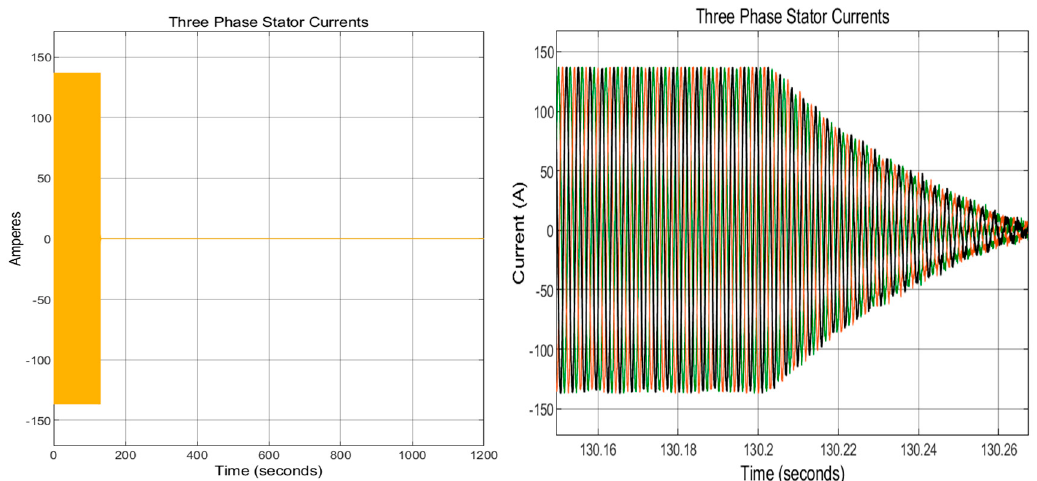
Figure 7. Three phase stator currents of IM during acceleration and standby mode.